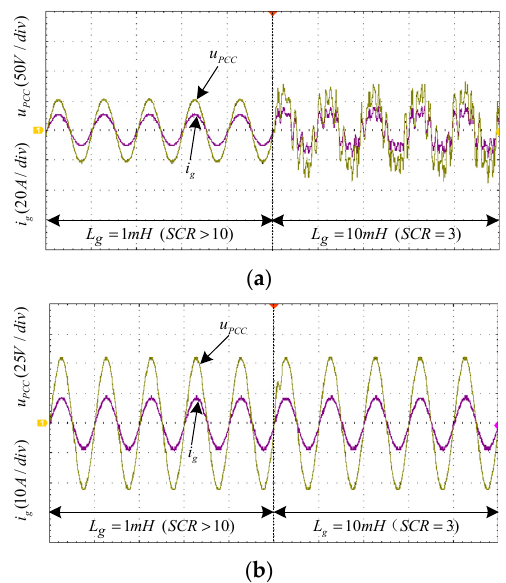
Figure 19. Experimental waveform of current and voltage at PCC when SCR changes: ( a ) with MFOF-PLL; ( b ) with CCF-MFOF-PLL.